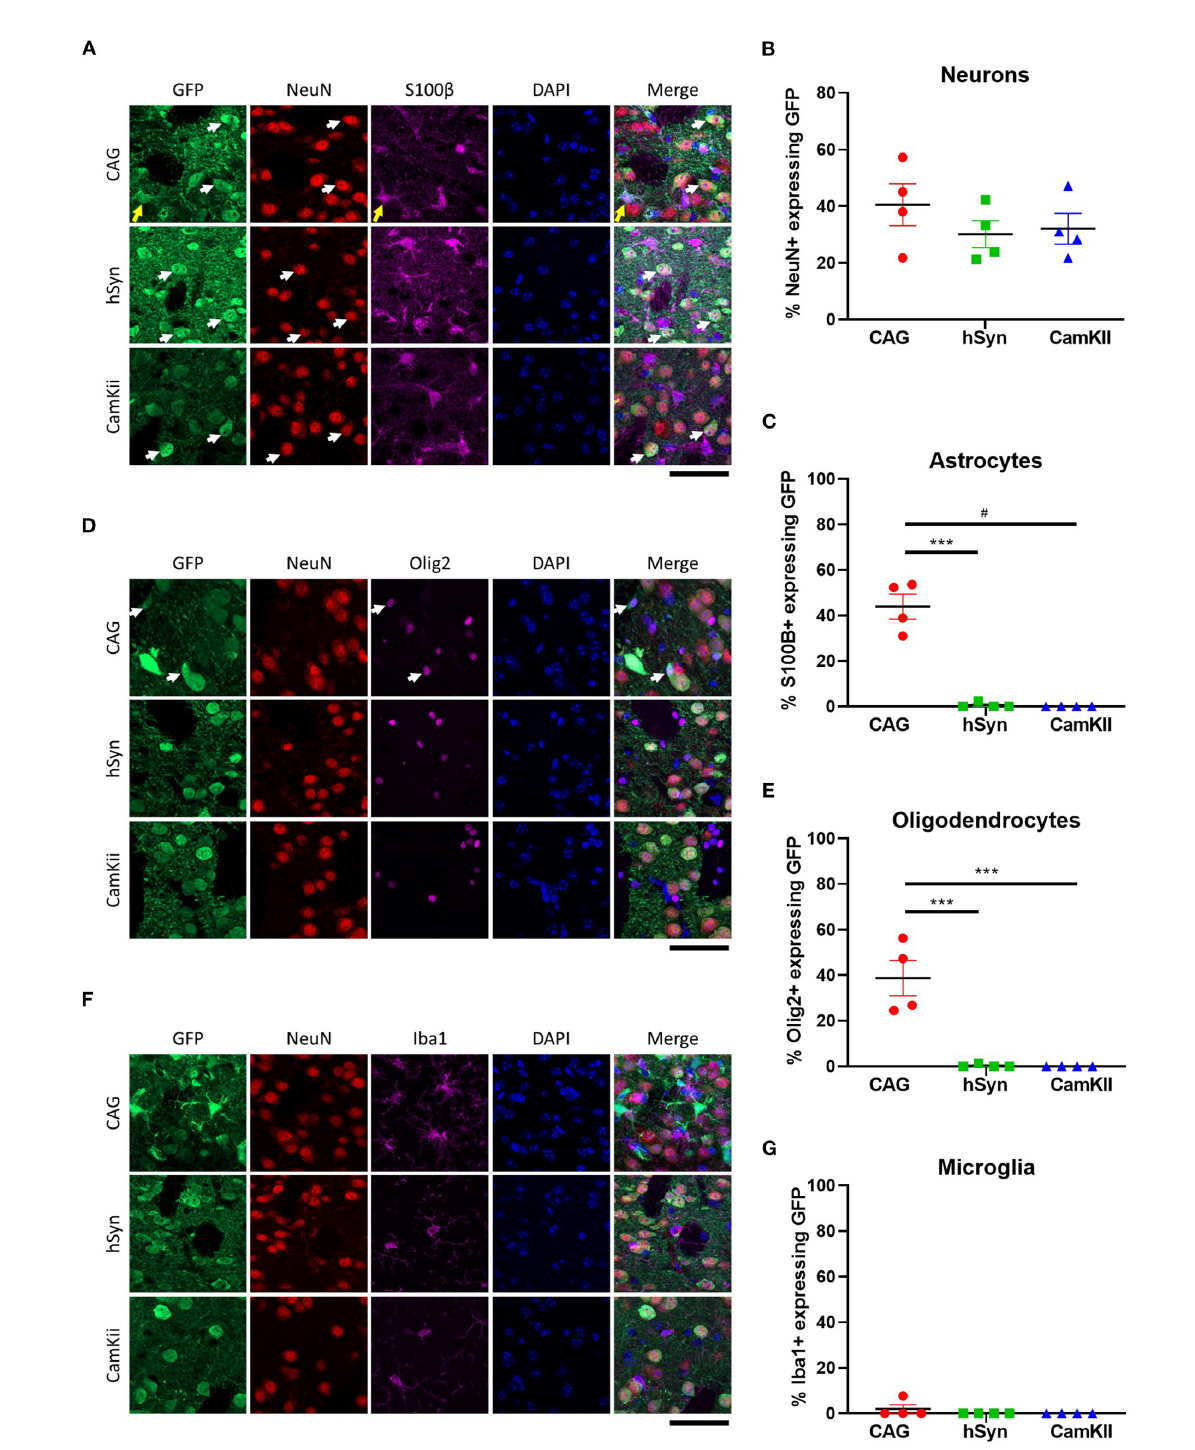
FIGURE3 Cell-type specificity of GFP expression in the striatum of mice. (A) Colocalization of GFP expression with markers of neurons [NeuN] and astrocytes [S100 β ]. Arrows point out cells with co-localization of GFP with NeuN (white) and S100B (yellow). Percentage of (B) neurons and (C) astrocytes that express GFP in the transduced area. (D) Colocalization of GFP expression with markers of oligodendrocytes (Olig2) and (E) percentage of oligodendrocytes that express GFP in the transduced area. White arrows point out cells with co-localization of GFP with Olig2. (F) Colocalization of GFP expression with markers of microglia (Iba1) and (G) percentage of microglia that express GFP in the transduced area. Scale bar represents 50 µ m. Data was analyzed using a one-way ANOVA followed by Tukey’s multiple comparisons test. *** p < 0.001 and # p <